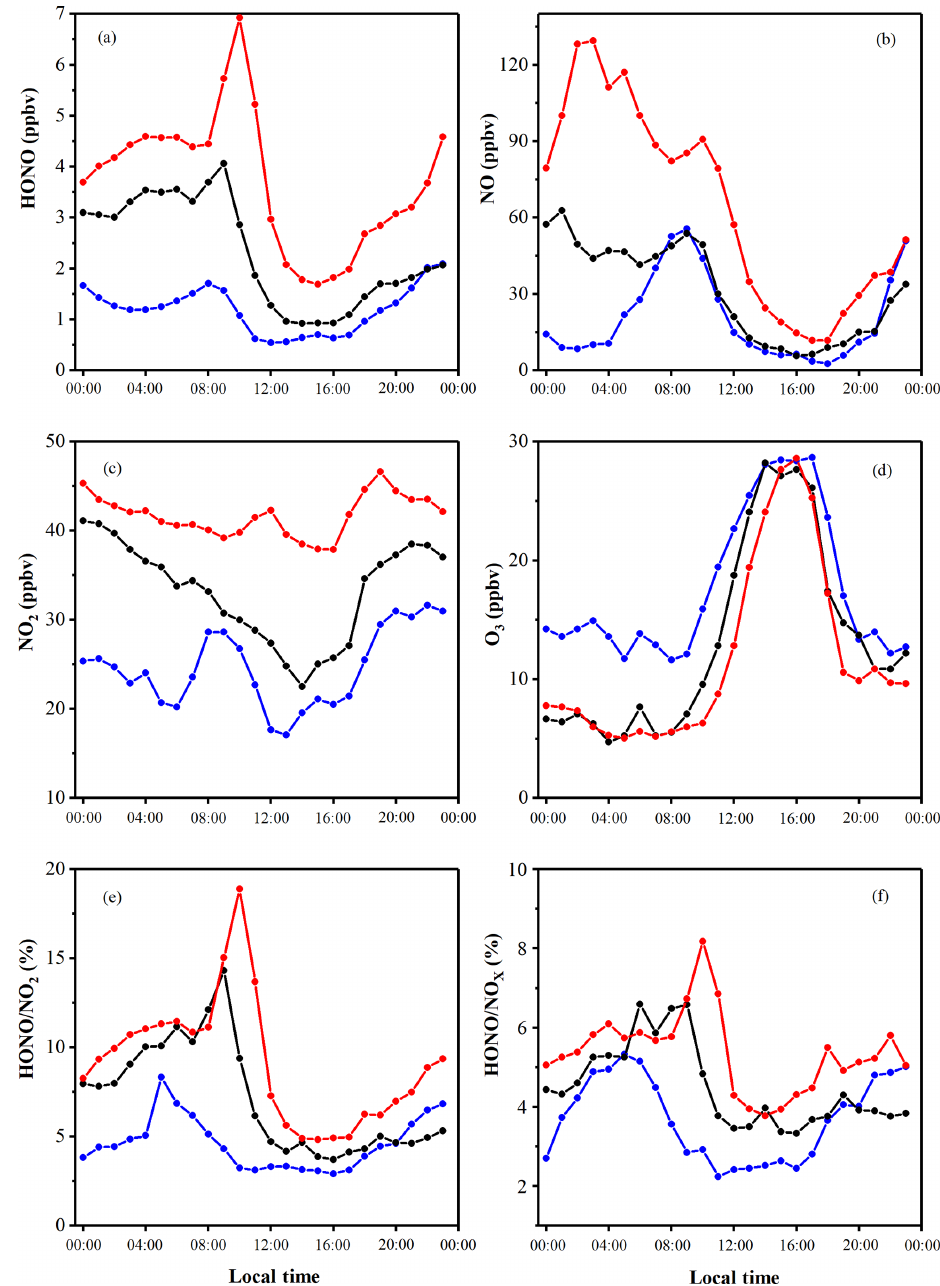
Figure 4. Diurnal variations of HONO, NO, NO 2 , O 3 , HONO / NO 2 , and HONO / NO x . The blue points and lines represent the CDs period; the black points and lines represent the PDs period; and the red points and lines represent the SPDs